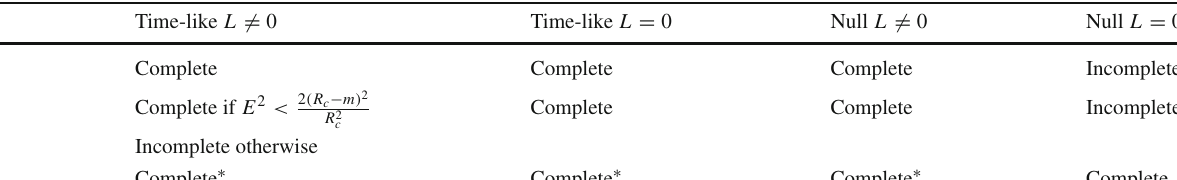
Table 2 Properties of the geodesics of the one-center solutions of GR ( s = 0) and of the two families of configurations studied in this paper ( s = ± 1). For clarifications on what Complete ∗ means, see the discussion in Sect. 4.2.4